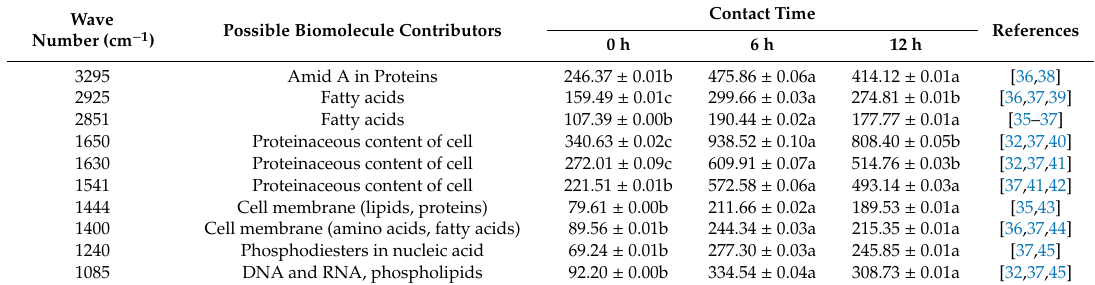
Table 3. Band area ( × 10 − 3 cm − 1 ) and band area changes of B. cereus treated with 0.1 % v / v of